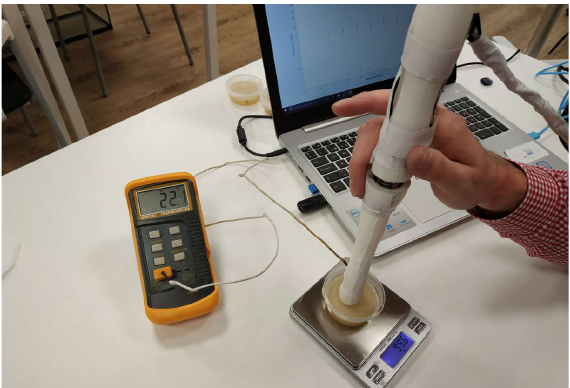
Figure 5. Picture of the experimental setup of TWE measurements. The phantoms were positioned on a balance to control the pressure